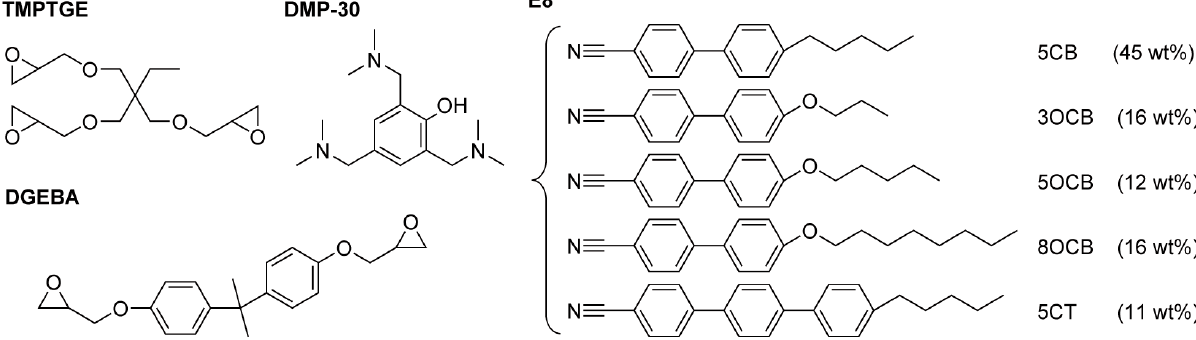
Figure 1. The chemical structures of the compounds used in this